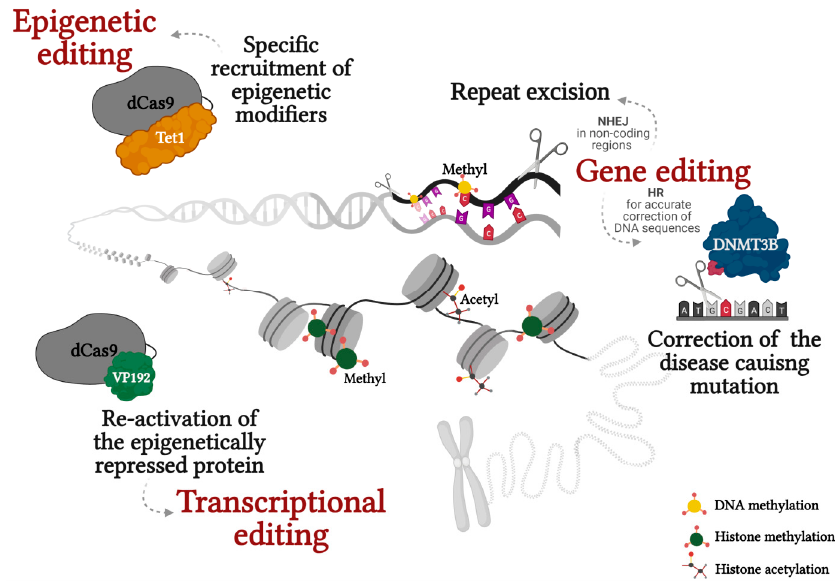
Figure 1. Correction of epimutations in repeat associated diseases through genetic, epigenetic and transcriptional editing. Created with BioRender.com.